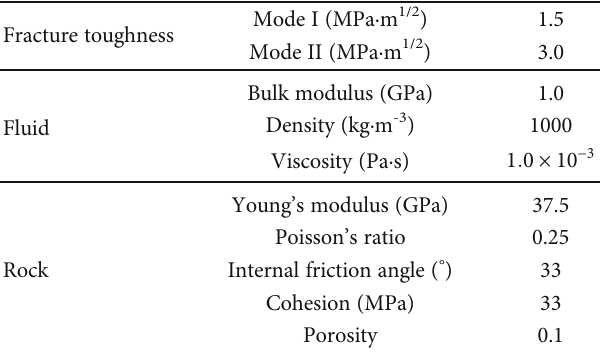
Table 2: Some input parameters for the validation case. Fracture